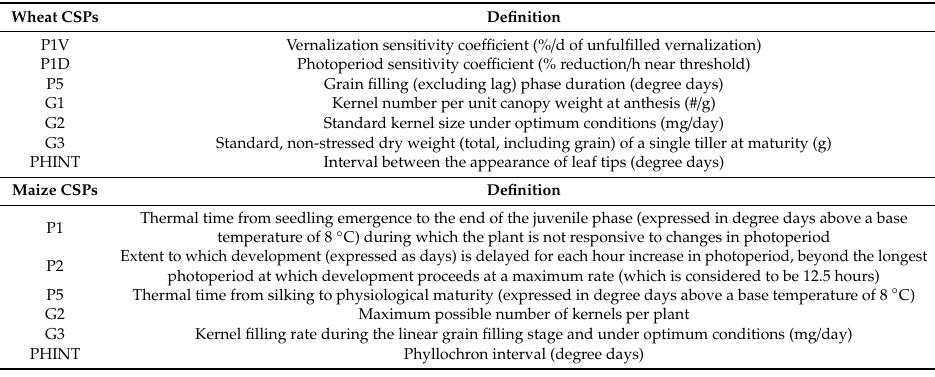
Table 1. Cultivar-specific parameters (CSPs) for CSM-CERES-Wheat and CSM-CERES-Maize crop